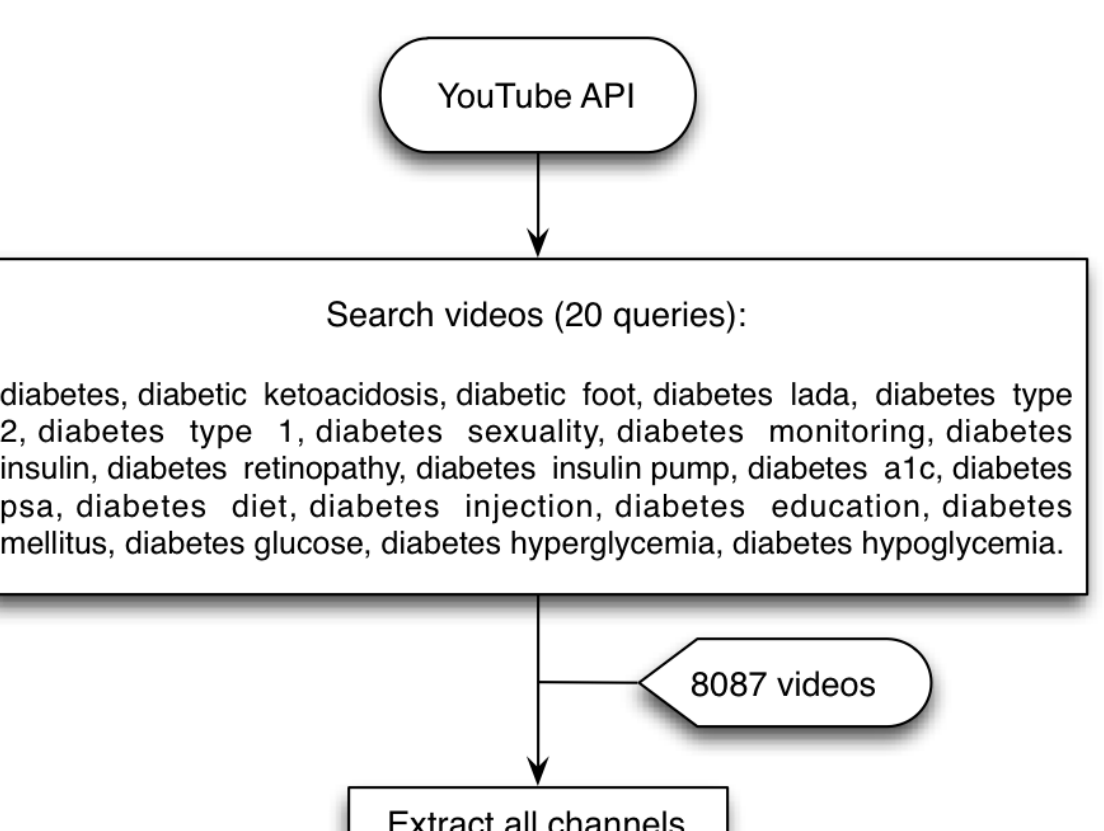
Figure 8. Data extraction on the search study on diabetes videos and HealthTrust. API = application programming interface; HITS = hyperlink-induced topic